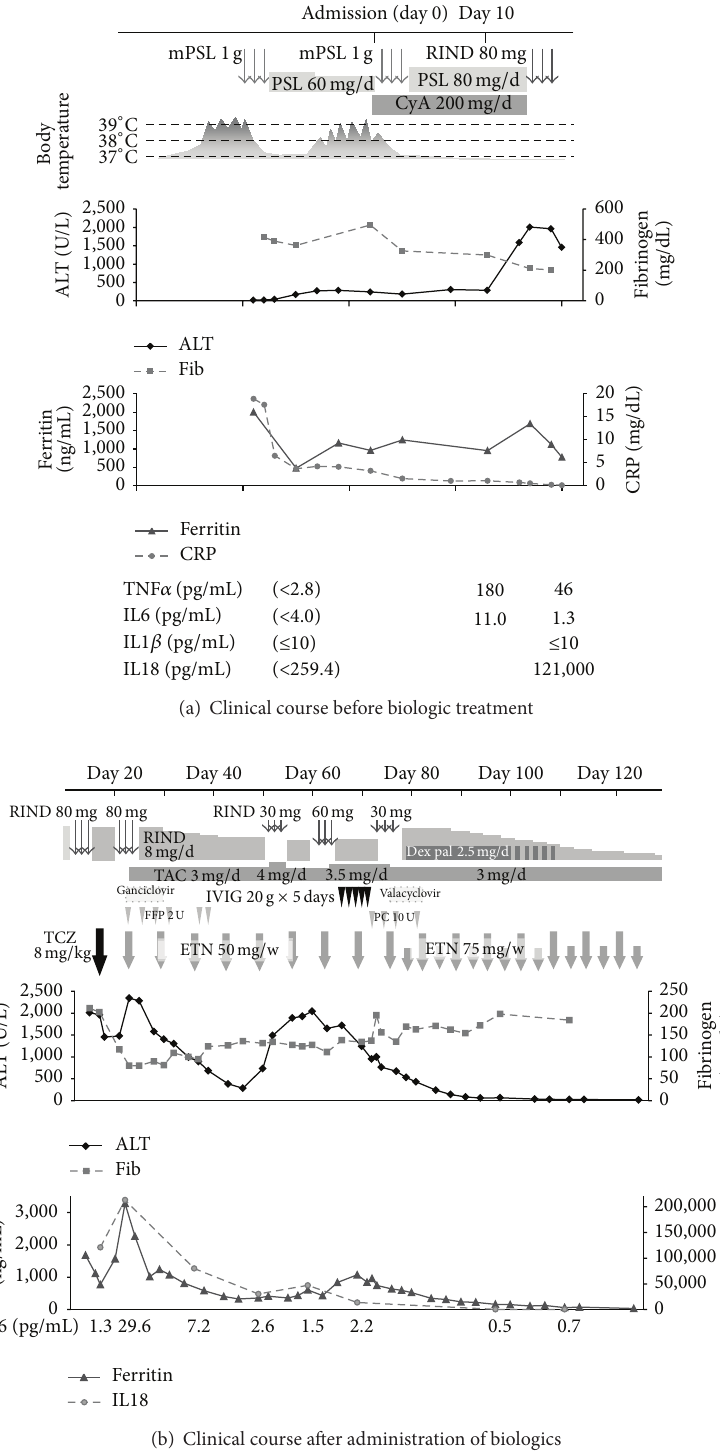
Figure 1: Patient’s treatment, liver function, and inflammatory biomarkers during the clinical course. ALT, alanine aminotransferase; CRP, C- reactive protein; CyA, cyclosporine; Dex-Pal, dexamethasone palmitate; ETN, etanercept; HD-IVIg, high-dose intravenous immunoglobulin therapy; IFN, interferon; IL, interleukin; mPSL, methylprednisolone; PSL, prednisolone; RIND (betamethasone), sIL2-R, soluble interleukin 2 receptor; TAC, tacrolimus; TCZ, tocilizumab. Cytokines were measured by SRL Inc. with the following kits; TNF 𝛼 , Quantikine HS Human TNF- 𝛼 immunoassay (R&D); interferon- 𝛾 , IFN- 𝛾 Human Direct ELISA Kit (Life Technologies Japan); IL1 𝛽 , IL-1 𝛽 Human ELISA Kit (Life Technologies Japan); IL6 Lumipulse human IL6 (Fuji Rebio); IL18, Human IL-18 ELISA kit (MBL). Reference values are as follows: TNF 𝛼 (normal < 2.8 pg/mL), IFN 𝛾 (normal < 0.1pg/mL), IL1 𝛽 (normal < 10pg/mL), IL6 (normal < 4pg/mL), IL18 (normal < 259.4